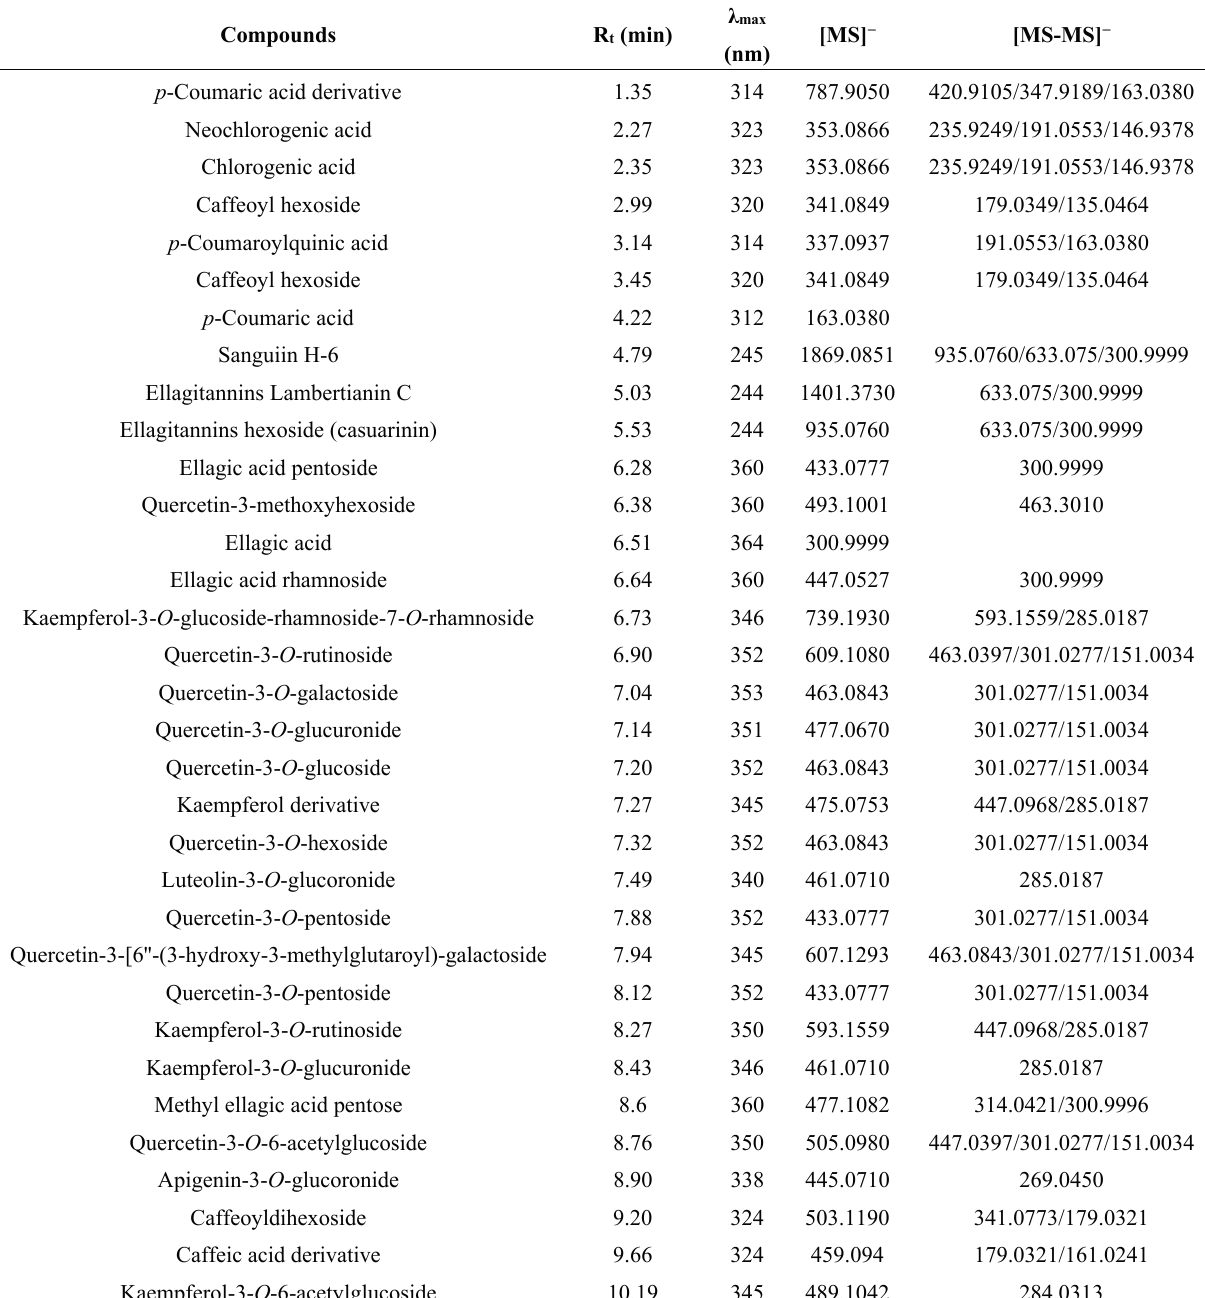
Table 1. The characterization of phenolic compounds in blackberry leaves, using their spectral characteristics in UPLC-PDA (retention time, λ max ) and negative ions in